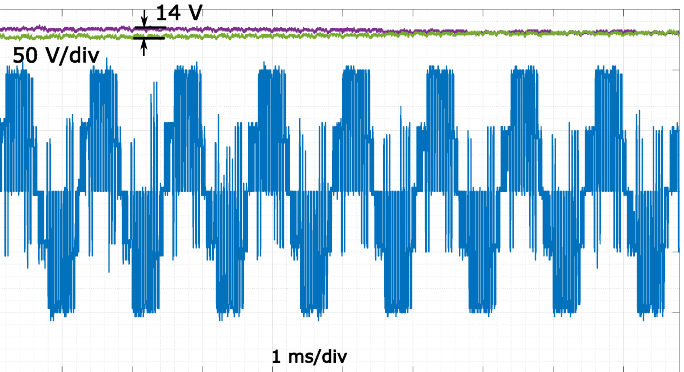
Figure 19. Experimental results of voltage balancing control with the proposed method.